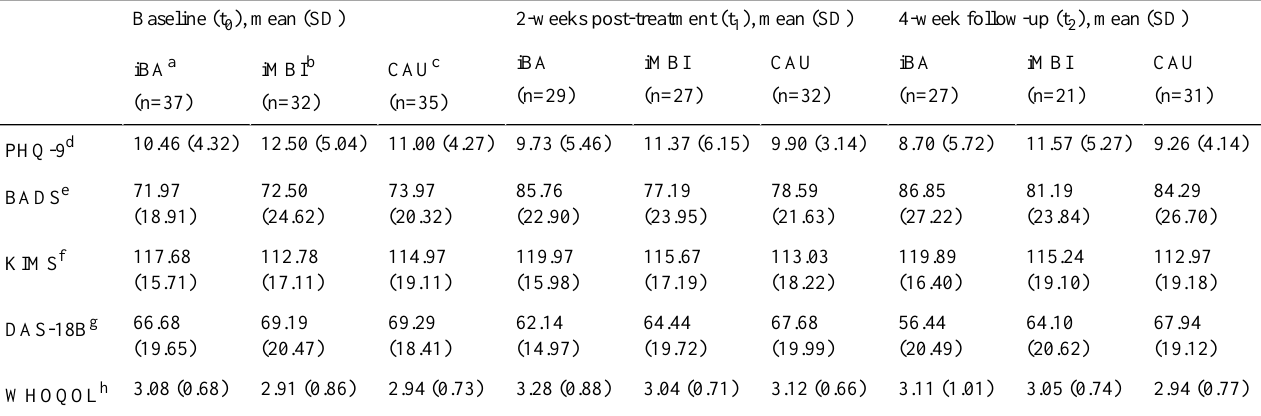
Table 2. Primary and secondary outcome measures in the complete-cases